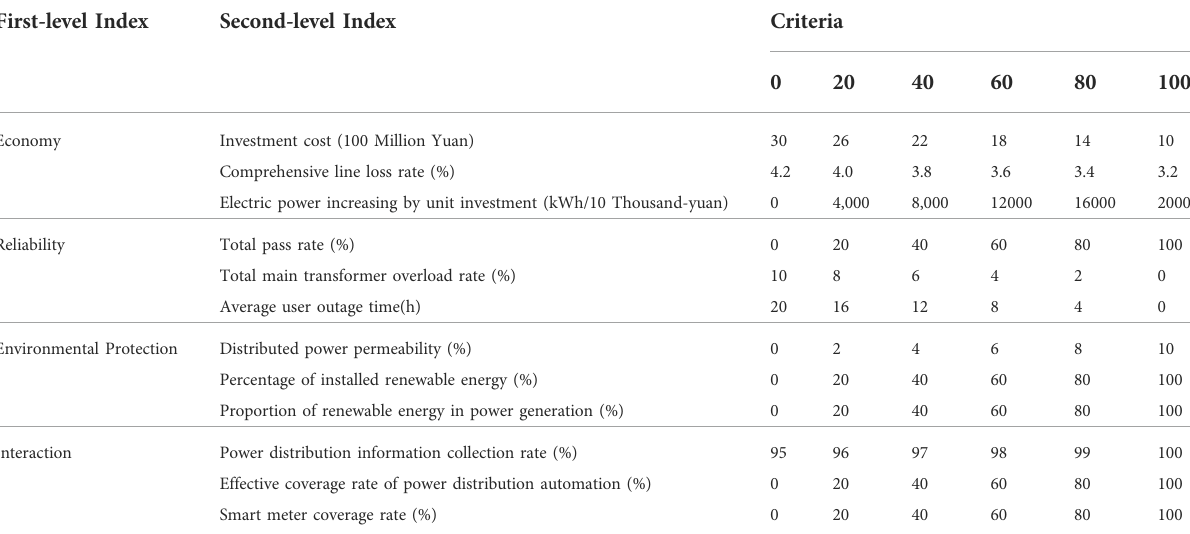
TABLE 1 Evaluation criteria of comprehensive evaluation indexes.